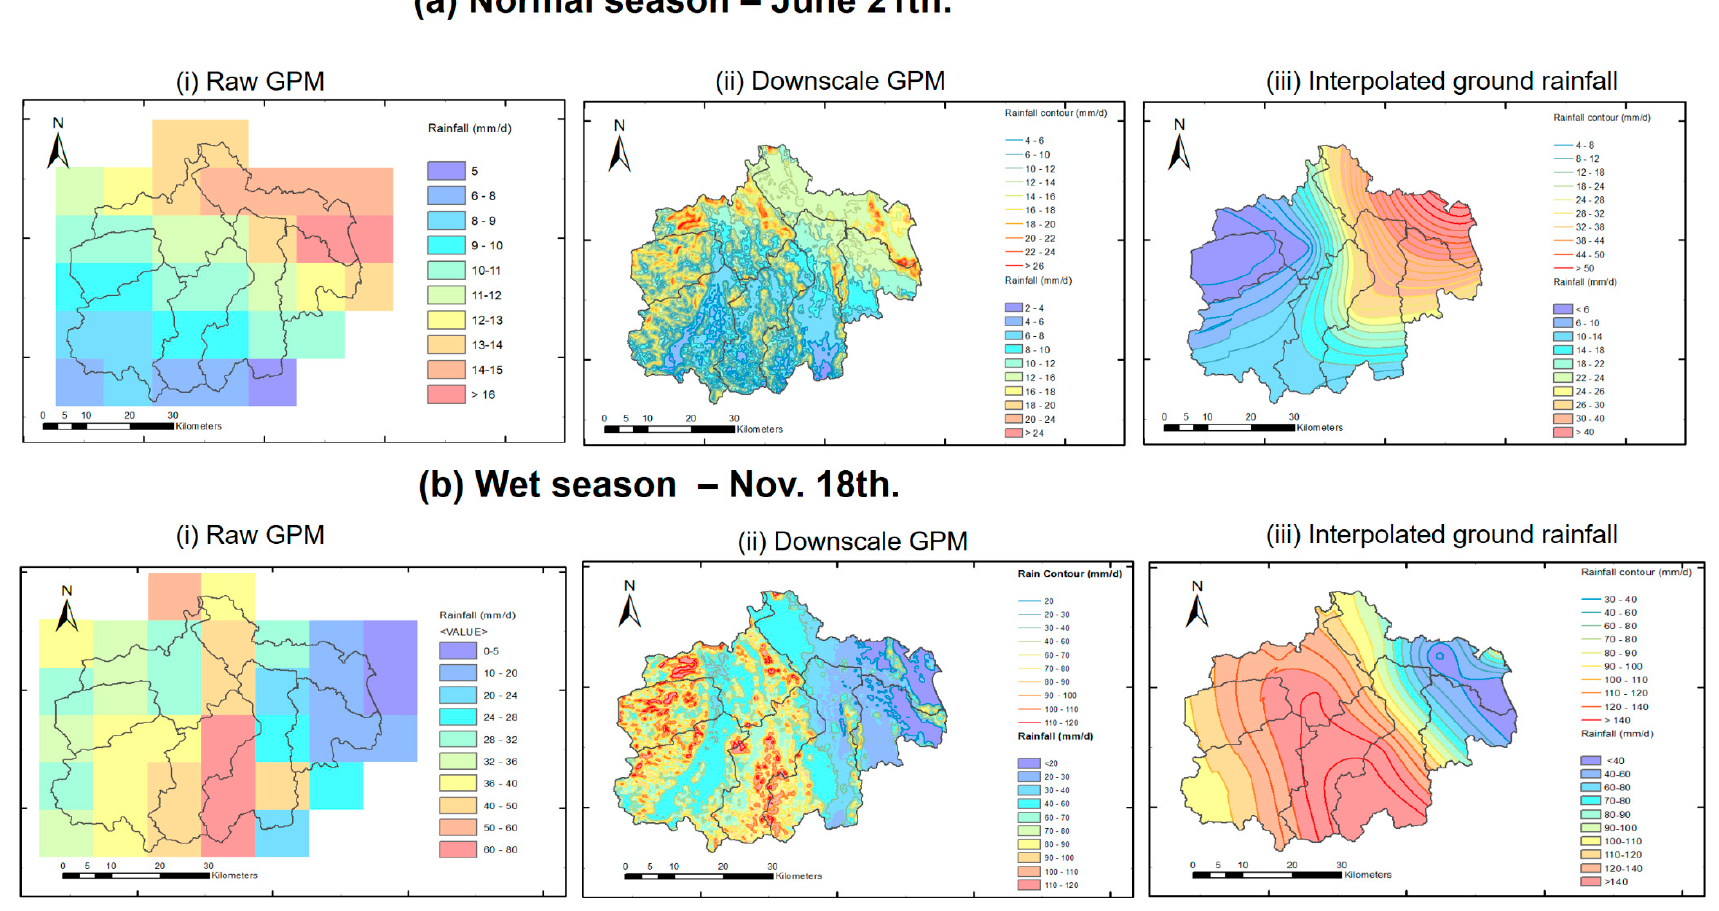
Figure 9. Samples of the raw and downscaled GPM rainfall maps and also the interpolated rainfall using the rain gauges. ( a ) Normal season; ( b ) wet season.